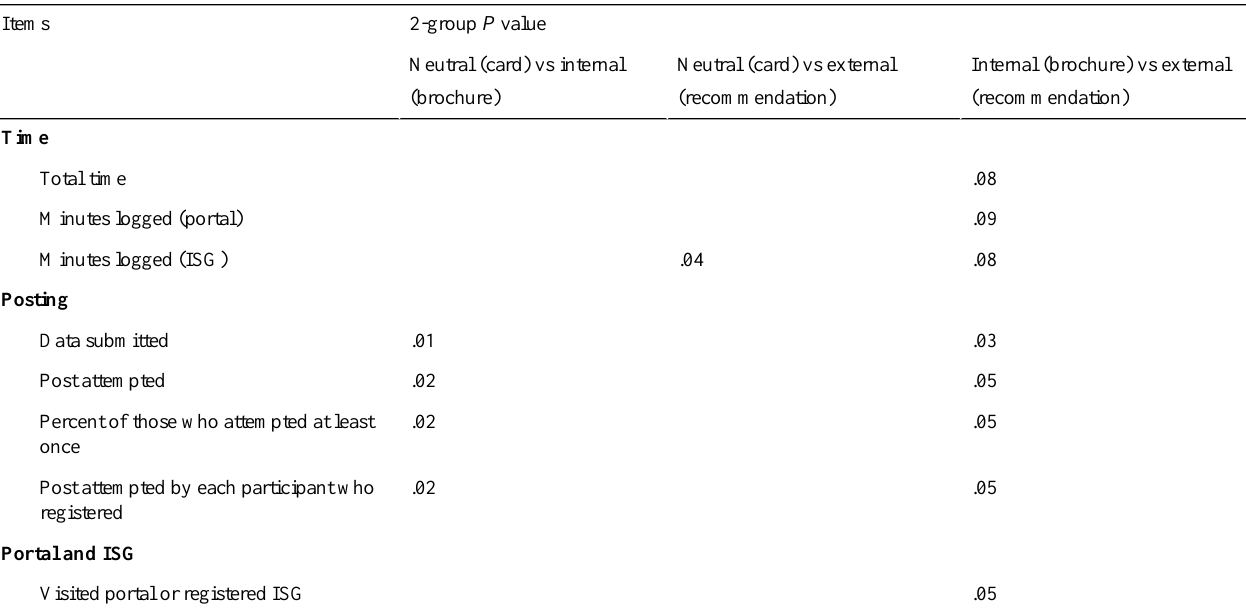
Table 5. Group comparisons of participation measures reporting only with P <.10. a